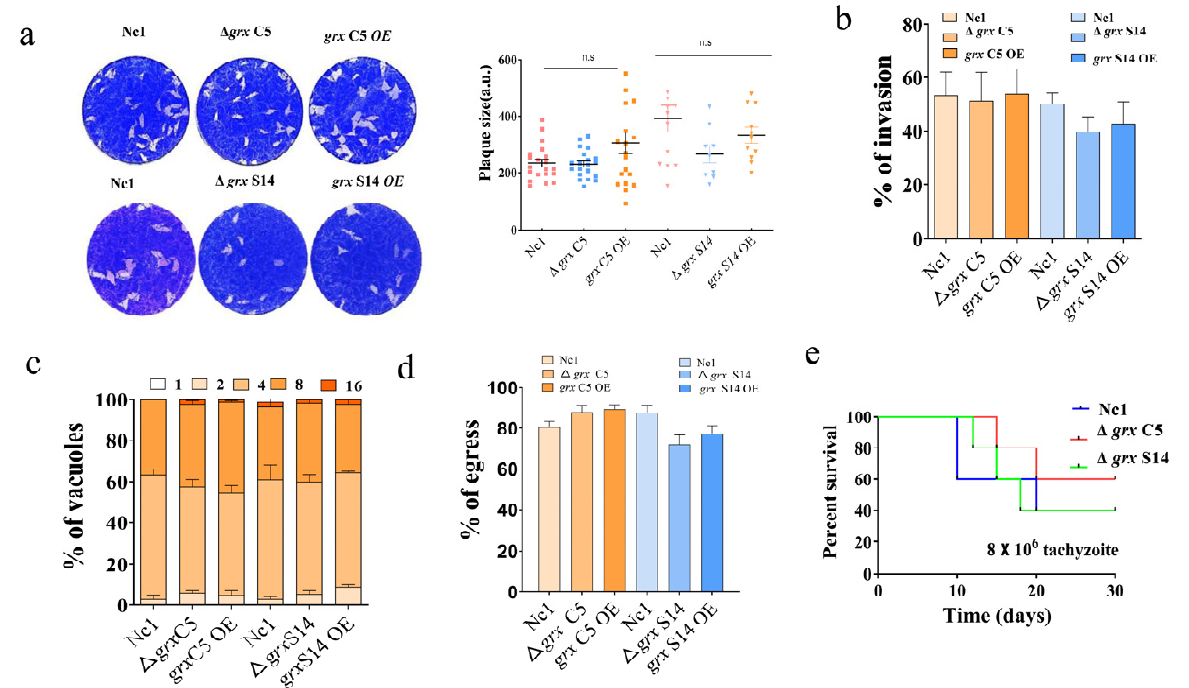
Figure 3. Lack of GRX S14 and GRX C5 alone did not affect the growth of parasites. ( a ) Plaque assays comparing growth of wild-type, knockout and overexpression parasites. Each well contained 300 parasites, and plaques were stained for 9 days. Plaque areas were counted by randomly selecting at least 20 plaques and measuring the pixel point with Photoshop C6S software (Adobe, San Jose, CA, USA). Data were compiled from three independent experiments. ( b ) A total of 1 × 10 5 parasites were inoculated on human foreskin fibroblast (HFF) cells in 12-well plates and cultured for 24 h. IFA was performed with anti-NcSRS2 antibodies and Hoechst staining. The invasion ratio of wild-type, knockout, overexpression and complementary parasites was based on the number of parasite-infecting cells divided by the number of total cells in one horizon. Data are the mean ± SD (error bars) of three independent experiments. Statistical analysis showed no significant difference ( ∆ grx C5, F (2, 6) = 0.06720, p = 0.9357; ∆ grx S14, F (2, 6) = 2.238, p = 0.1879). ( c ) Intracellular replication of different parasite strains was compiled from three separate assays, with 100 total PVs of each strain counted in each assay. Statistical analysis showed no change ( ∆ grx C5, F (8, 15) = 0.6462, p = 0.7287; ∆ grx S14, F (8, 15) = 0.6732, p =0.7080). ( d ) The egress ability of parasites was assessed after treatment with the calcium ionophore A23187. IFA was employed to detect the integrity of the parasitophorous vacuole (PV). The average number of ruptured PVs was determined by counting 100 random vacuoles per slide. Statistical analysis showed no significant difference ( ∆ grx C5, F (2, 6) = 2.734, p = 0.1432; ∆ grx S14, F (2, 6) = 3.622, p = 0.0930). ( e ) Mouse survival after infection with different strains. BALB/c mice ( n = 5) were injected intraperitoneally with 8 × 10 6 doses of parasites. Statistical analysis was performed using the survival curve of GraphPad Prism (San Diego, CA,